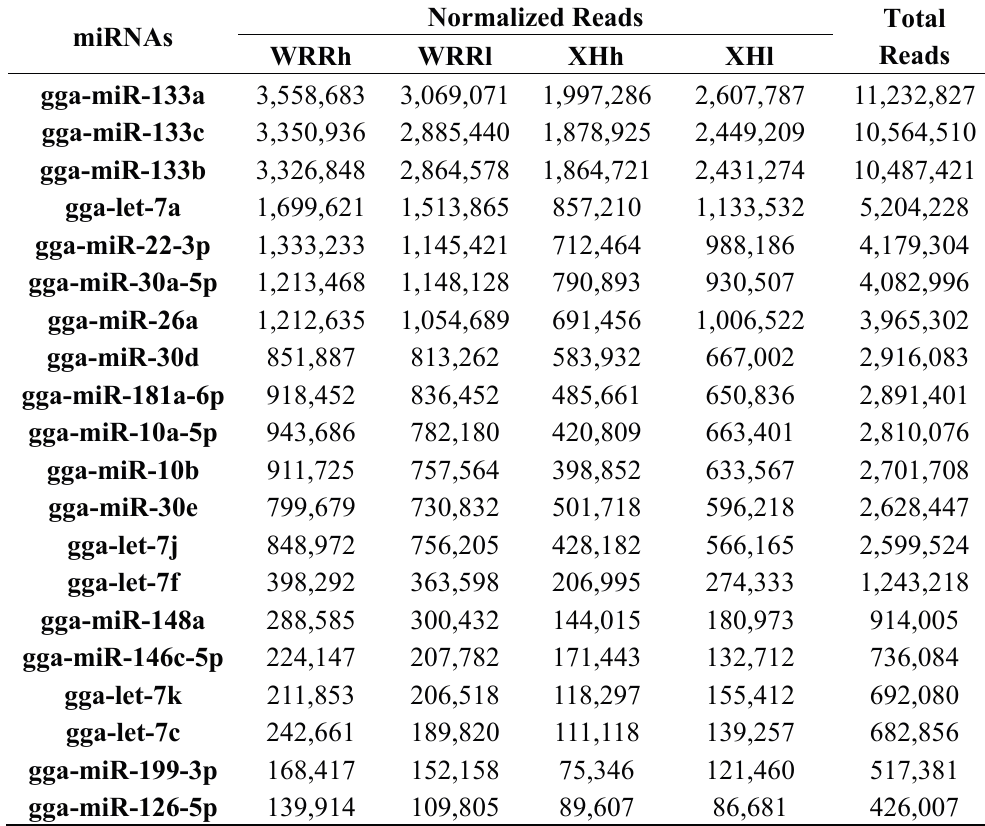
Table 2. The top 20 abundant known miRNAs in chicken breast muscles. Normalized miRNAs